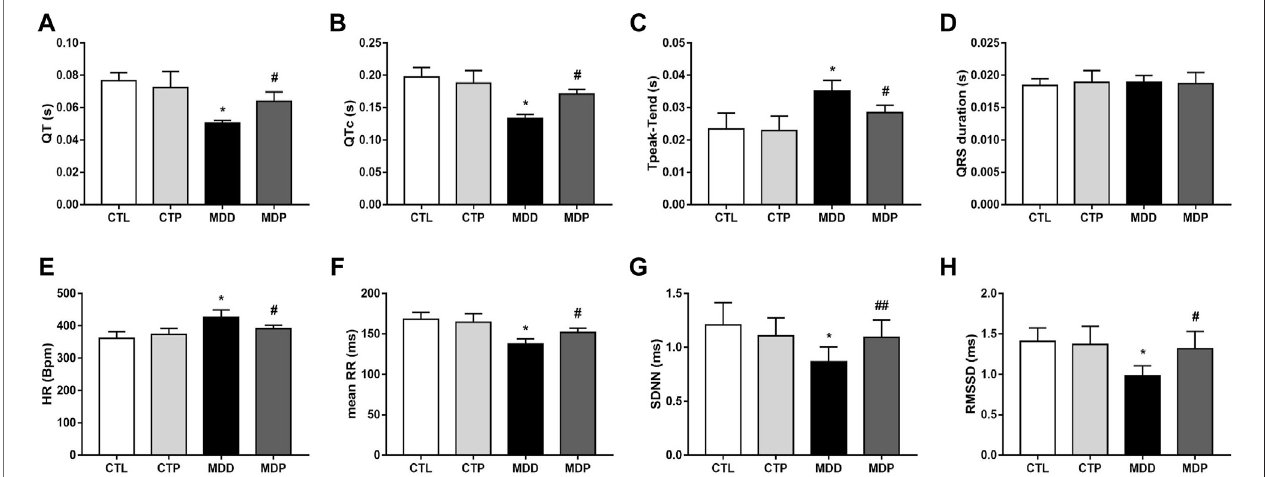
FIGURE6| Electrocardiogramparametersand HRV.(A – D)QTinterval, correctedQTinterval,Tpeak – TendintervalandQRSinterval, respectively. n (cid:1) 7pergroup. (E – H) Statistical analysis of HR, mean RR, SDNN, and RMSSD, respectively. n 7 per group. *p < 0.01 vs. CTL; #p < 0.01 vs. MDD; ##p < 0.05 vs. MDD. HRV, heart rate